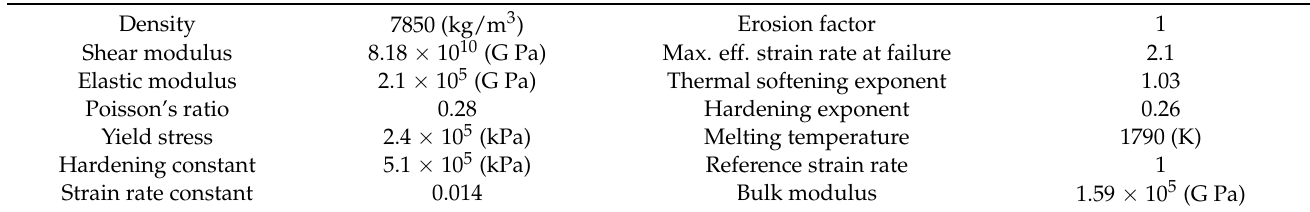
Table 1. The properties of the used steel (steel 37) [75].